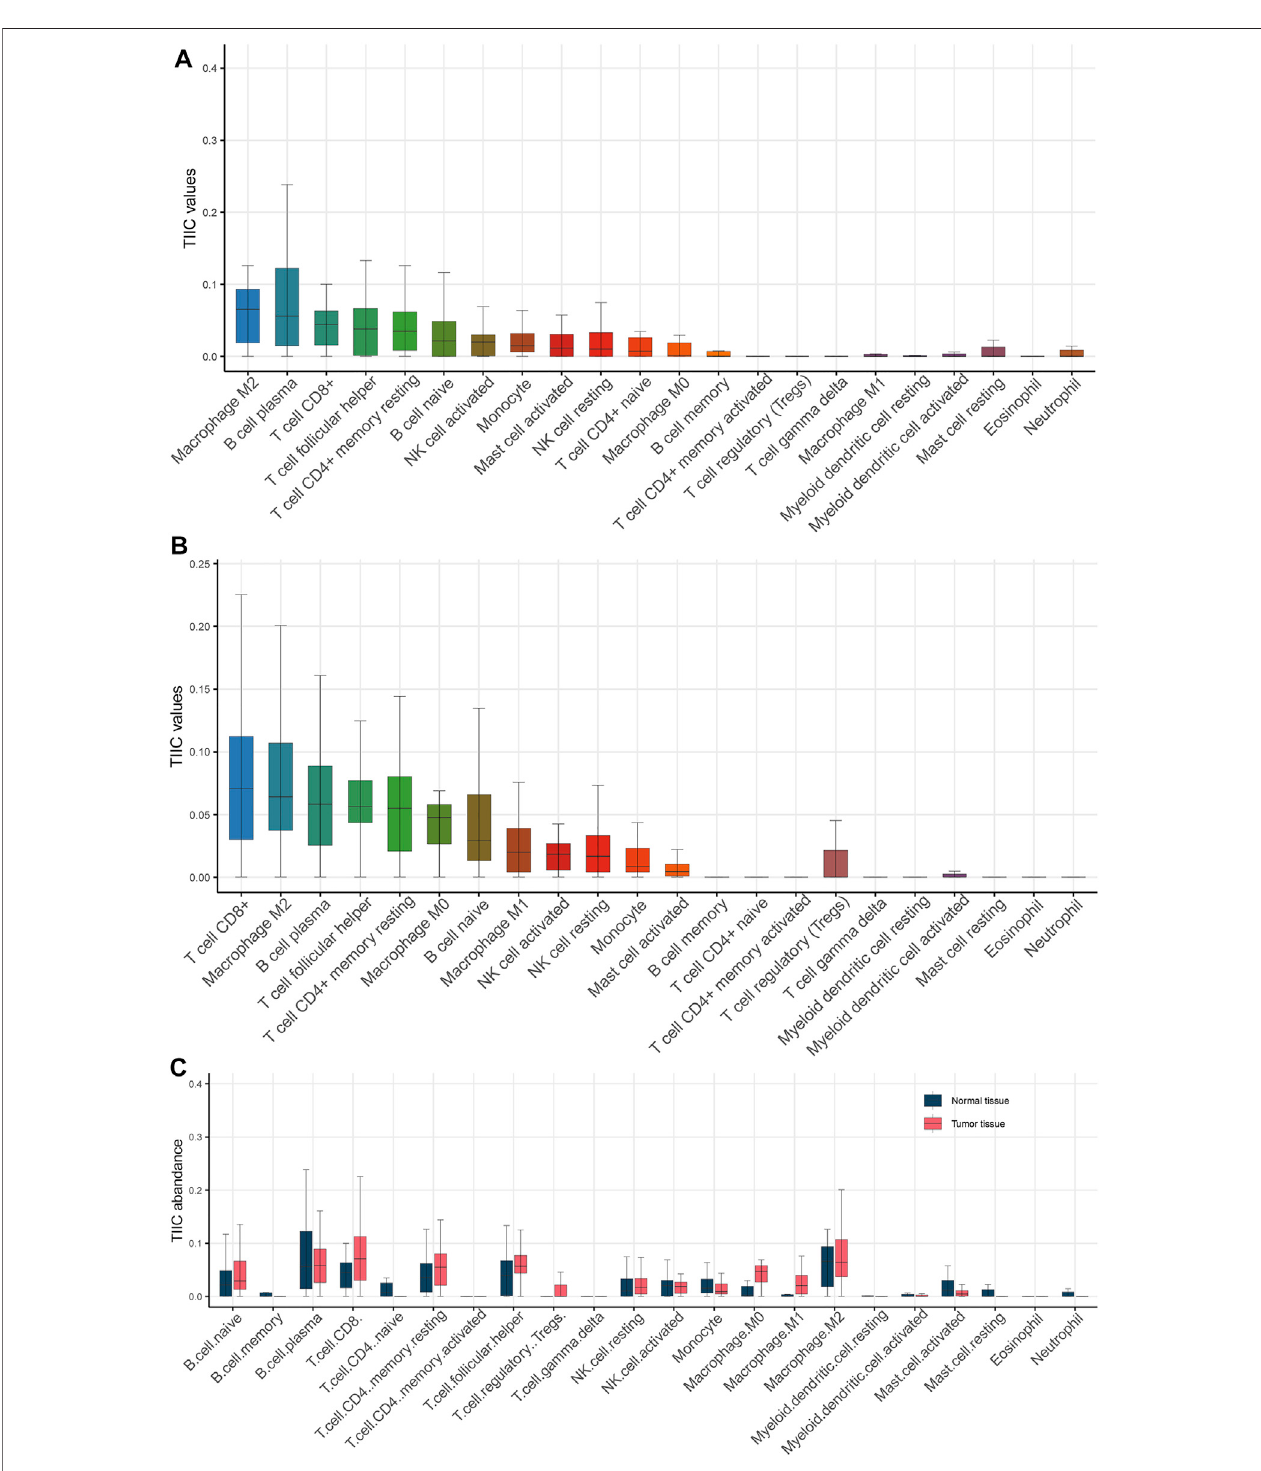
FIGURE 3 | Estimation of the abundance of tumor in fi ltrating immune cells. (A) Various types of immune cells in normal tissue. (B) Various types of immune cells in cancerous tissue. (C) Boxplot showed that CD8 + T cell, M0 macrophage, M1 macrophage, regulatory T cell and follicular helper T cell were signi fi cantly elevated in cancerous tissue as compared with normal